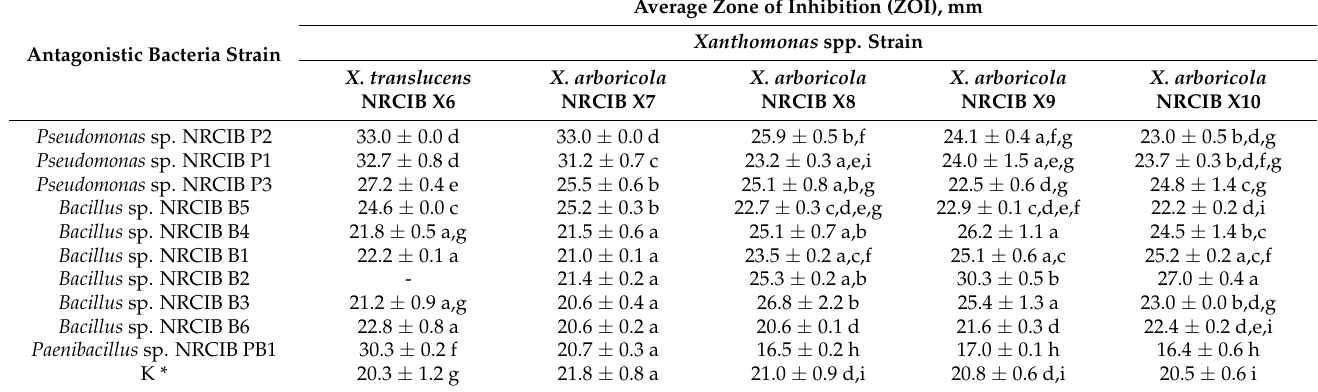
Table 1. Antibacterial activity of different endophytic bacterial strains against pathogenic Xanthomonas spp. strains.